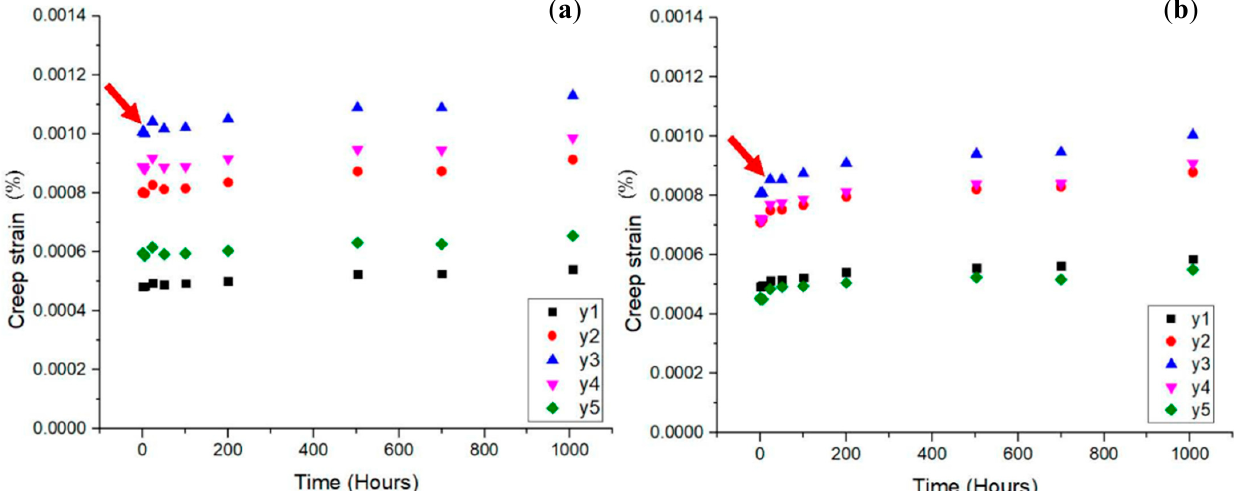
Figure 8. Creep strain against time of right main member of wooden cross arm for ( a ) the current design and ( b ) the design with the addition of a bracing system [23]. Reproduced with copyright permission from Creative Commons Attribution License 3.0.